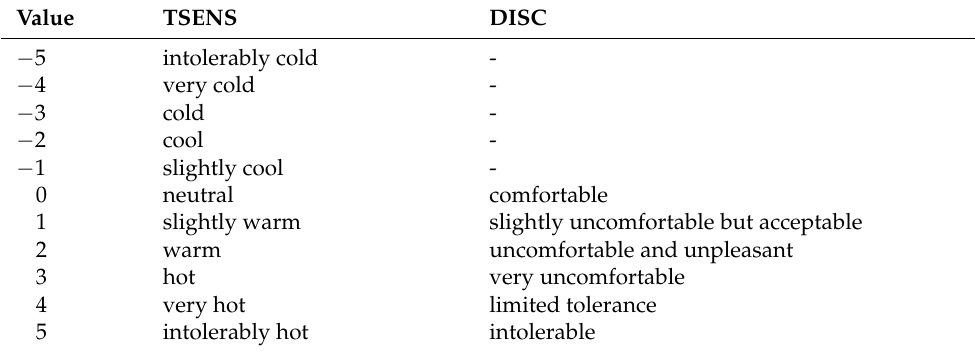
Table 2. Values of thermal sensation (TSENS) and discomfort (DISC) according to the ASHRAE